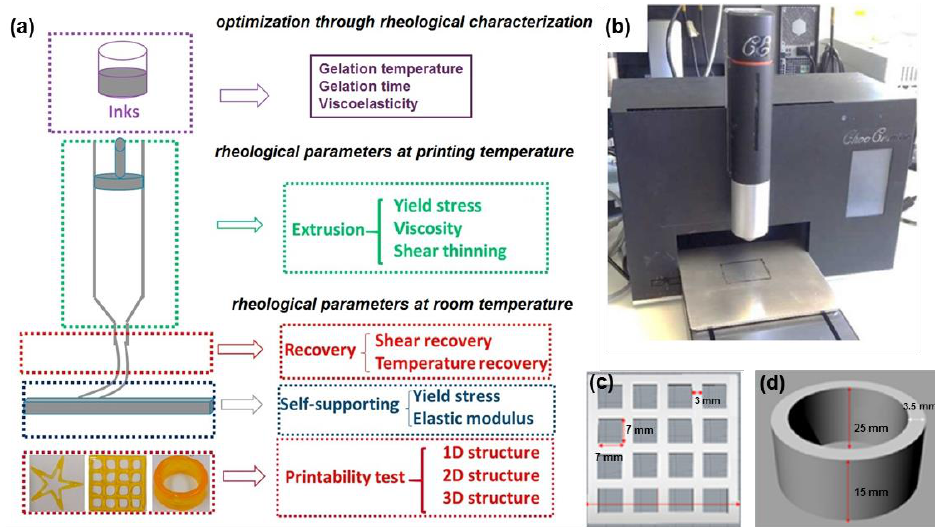
Figure 1. ( a ) Rheological tests required for testing printability of multicomponent food inks (carrageenan–xanthan–starch gels) as 1D (pentagram), 2D (lattice scaffold) or 3D (cylinder) structures; ( b ) photograph of the printer; Examples of printed shapes: ( c ) lattice scaffold or ( d ) hollow cylinder. Adapted with permission from ref. [56] copyright 2018 Elsevier Ltd.